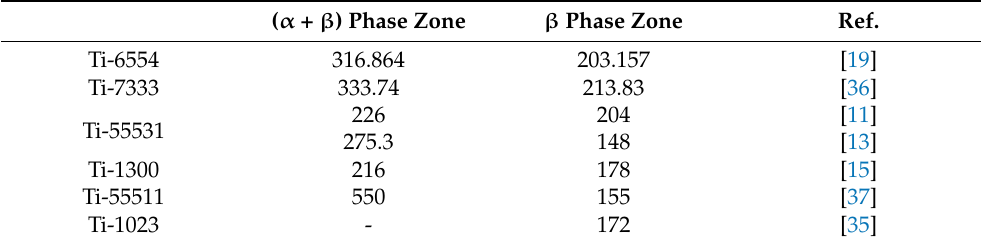
Table 1. Deformation activation energy of near- β titanium alloys (kJ · mol − 1